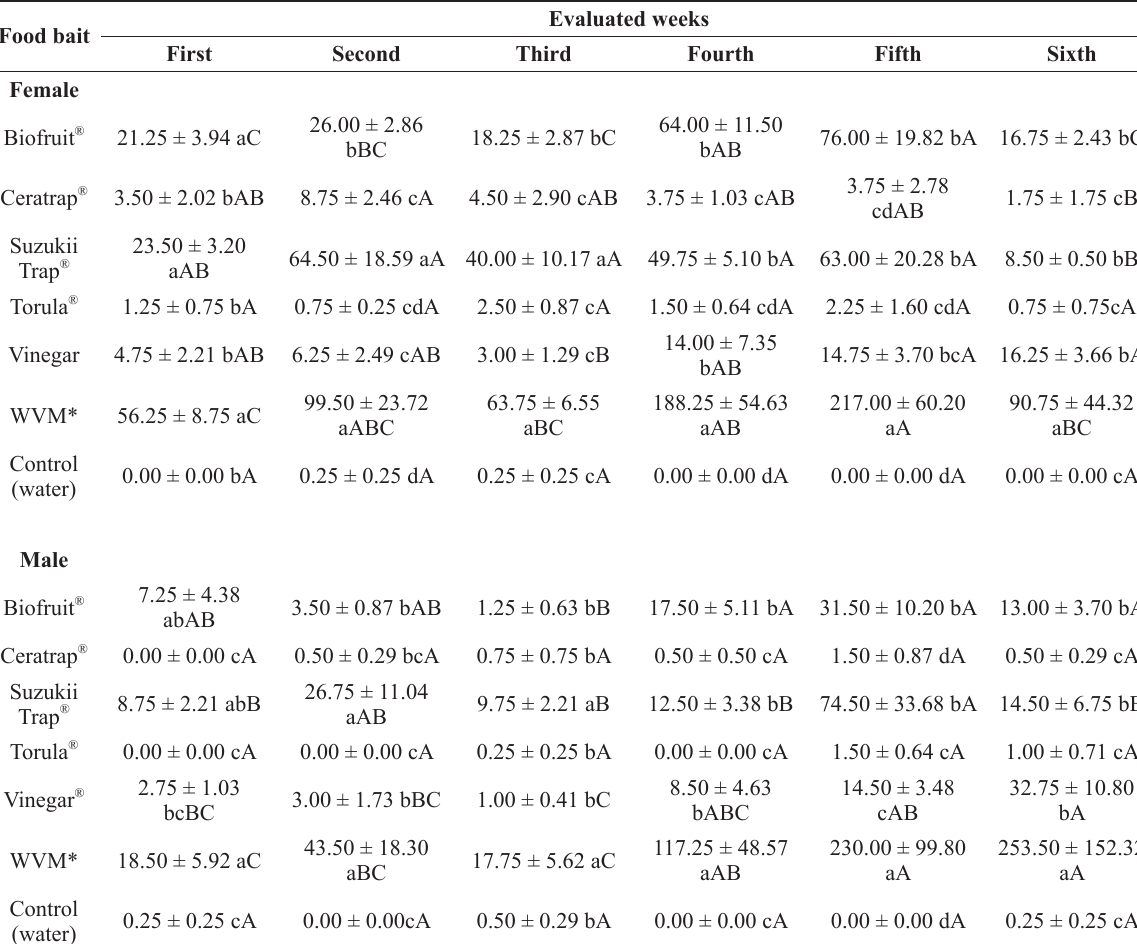
Number (mean ± standard error) of females and males of Drosophila suzukii captured with different food baits in a blackberry